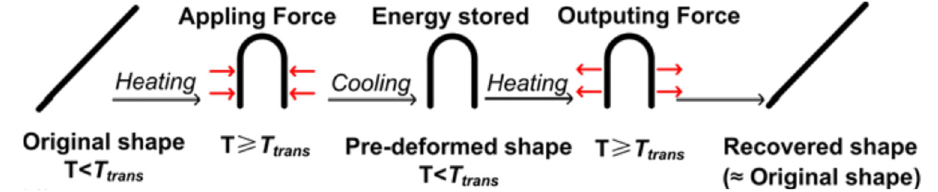
Figure 3: Schematic of shape memory e ff ect during typical thermo - mechanical cycle ( 41 ) . Reproduced with permission from